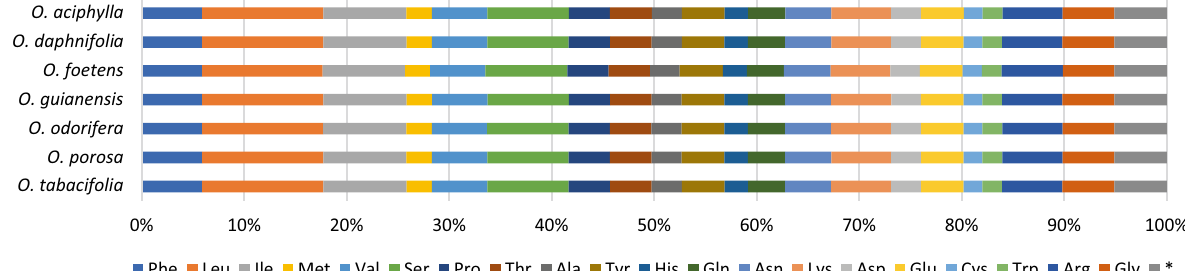
Figure 5. Amino acid percentage of protein-coding genes in seven Ocotea